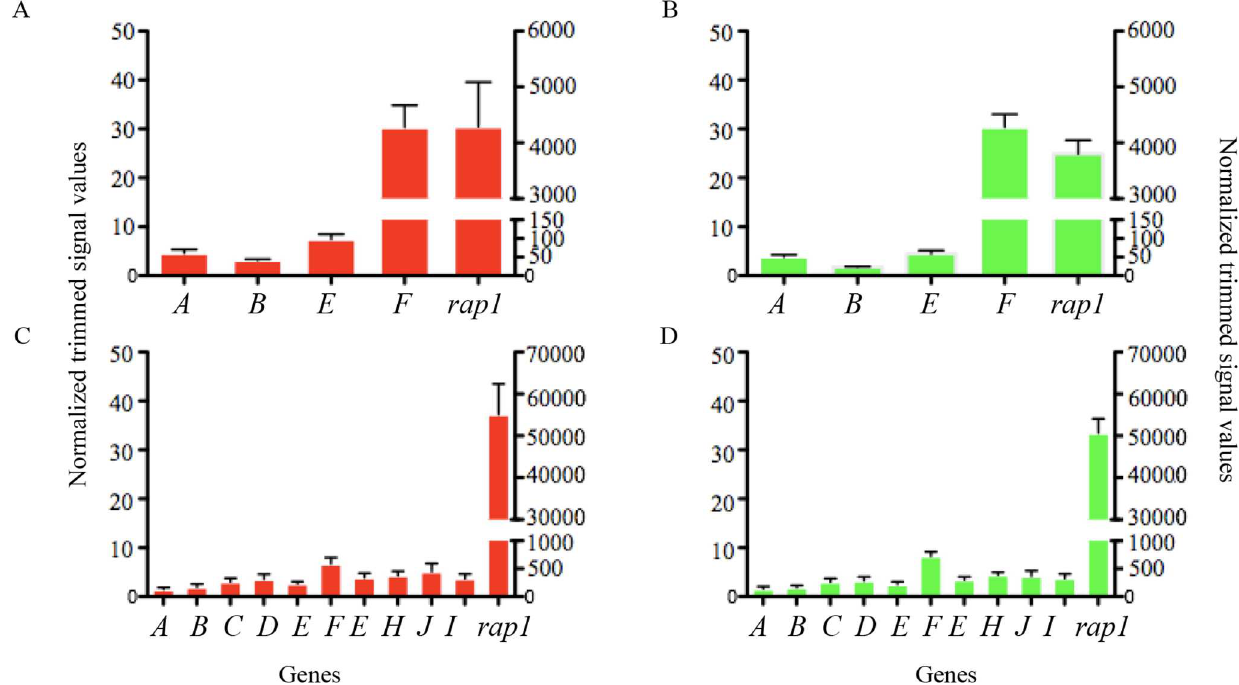
Fig 3. Transcriptional analysis of the Bbo 6-Cys genes in cultured blood stages. A. and B. RNA seq analysis performed on the virulent (red) and attenuated(blue) parasites derivedfrom the L17 strain of B . bovis . The Y axis indicates relative transcriptional levels. The X axis represents the name of the 6-Cys and rap-1 control genes. Transcripts for the B . bovis 6-Cys genes C , D , G , H , I and J were not detected using RNA seq. C. and D. Microarray analysisof the virulent (red) and attenuated(blue) parasites derived from the T2Bo strain of B . bovis . The Y axis indicatesrelative transcriptional levels. The X axis represents the name of the 6-Cys and rap-1 control genes.